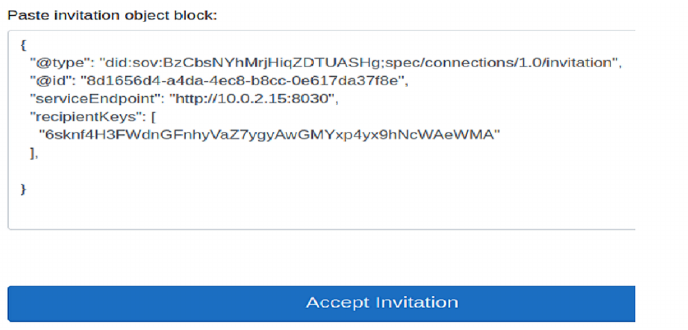
Figure 7. Bob’s credential in the Hyperledger Indy.